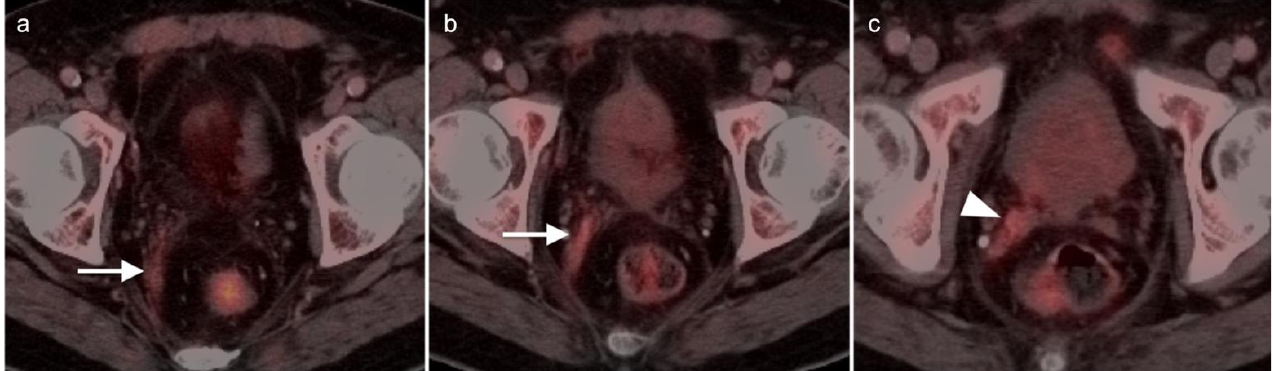
Figure 33. Tumor involving the left neurovascular pedicle by PSMA PET-CT ( a , b ). This patient had a radical prostatectomy and seminal vesicles were removed. Involvement of the left neurovascular pedicle (white arrowhead) could be confused with seminal vesicle without knowledge of the surgery performed.